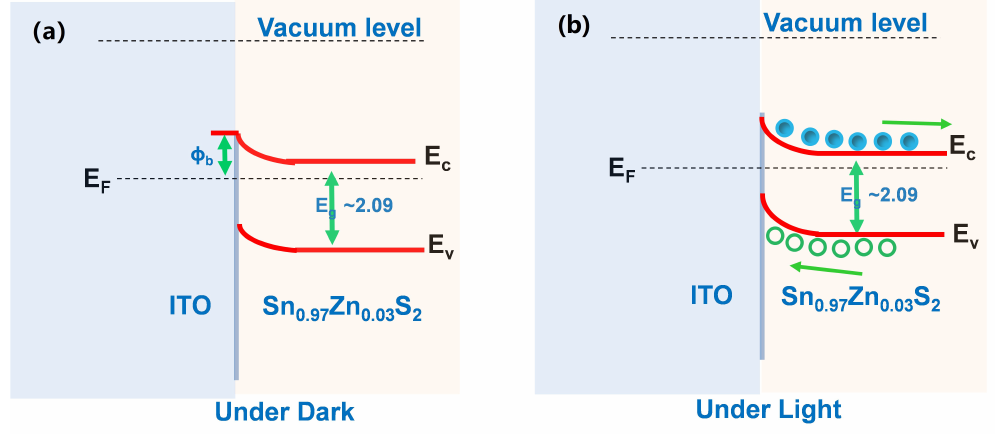
Figure 10. Energy diagram of the Sn 0.97 Zn 0.03 S 2 / ITO Schottky junction under ( a ) dark and ( b ) illumination conditions.